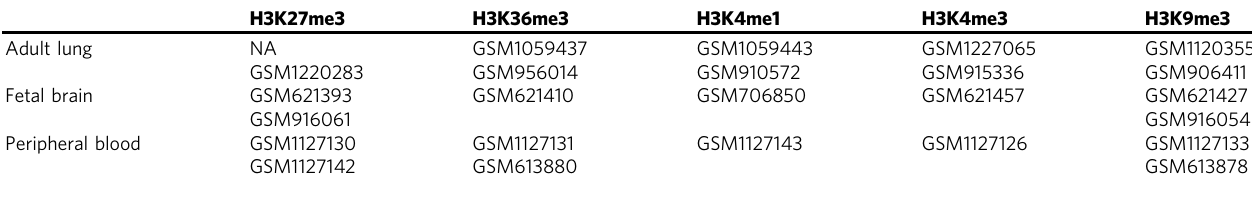
Table 4 Samples downloaded from Roadmap Epigenomics Project for 5 different histone modi fi